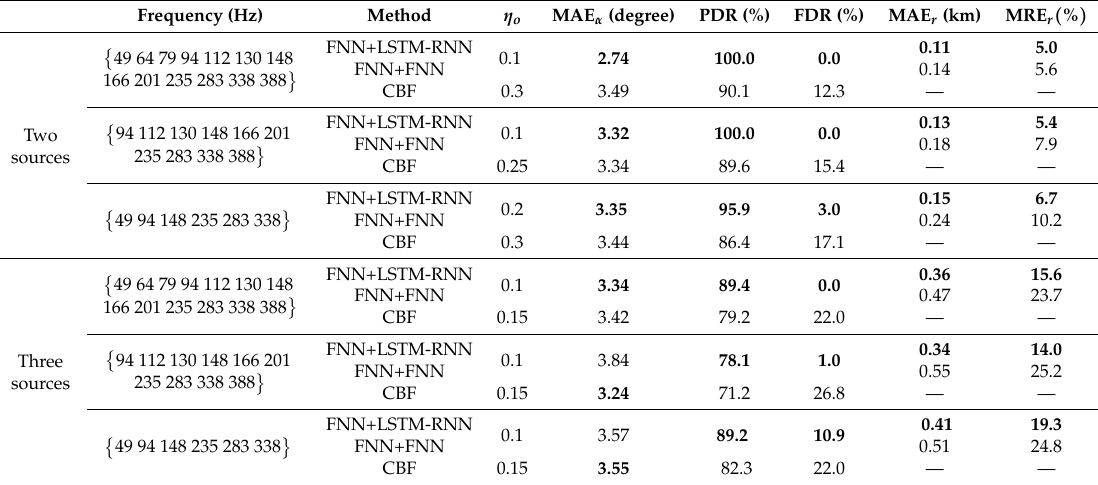
Table 6. The performance comparison with different frequency bins in the two-source and three-source scenarios using the real experimental